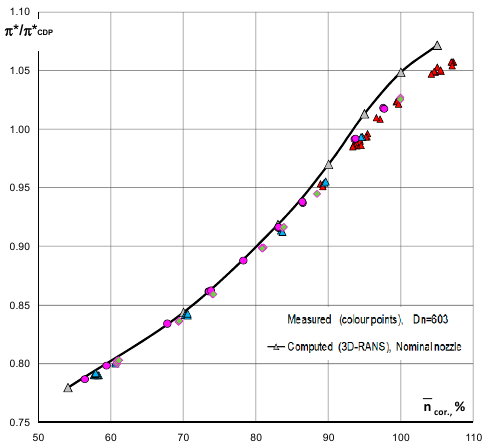
Figure 10. Comparison of calculated and experimental π * / π * CDP values along operating line at CDP ( n cor = 95%). Int. J. Turbomach. Propuls. Power 2018 , 3 , x FOR PEER REVIEW